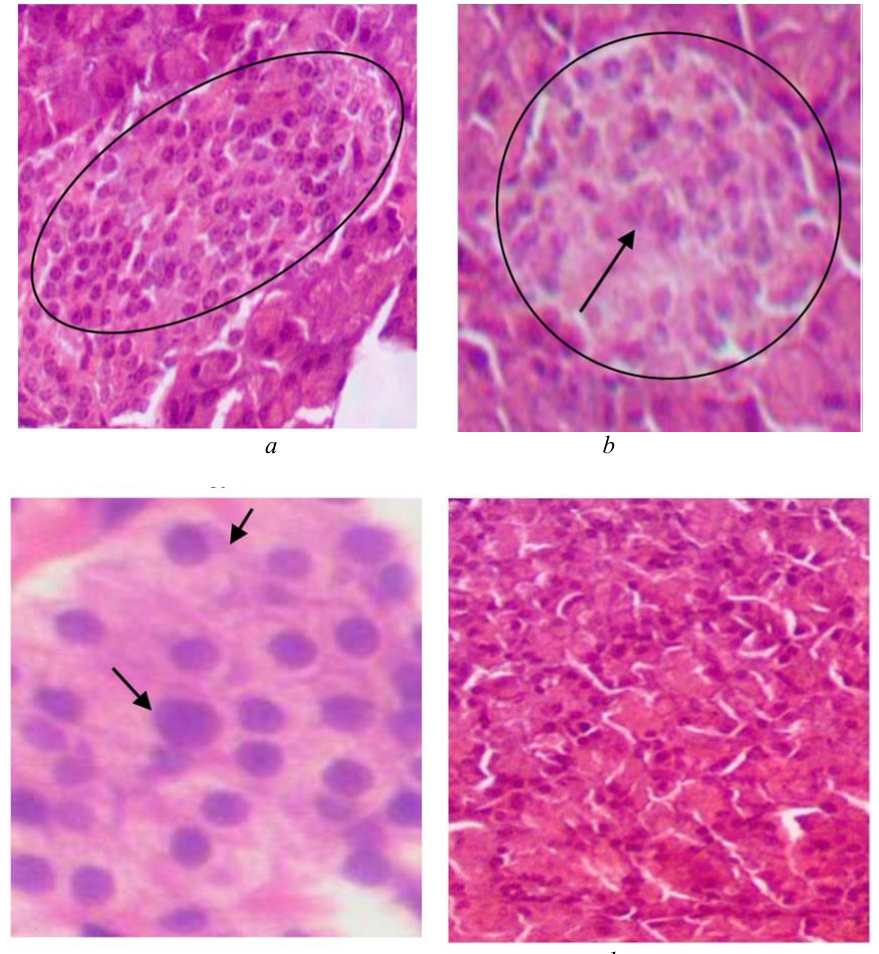
Fig. 6. The pancreas of Syrian hamsters, who received a species "Arphasetin" on the background of a diet rich in fats and fructose: a – the normal condition of the pancreatic islet and β -cells; b – focal devastation, destruction of β –cells c – hypertrophy of the β -cells; d – unchanged acinar parenchyma. Hematoxylin-eosin; a, b – ×250; c – ×400; d –